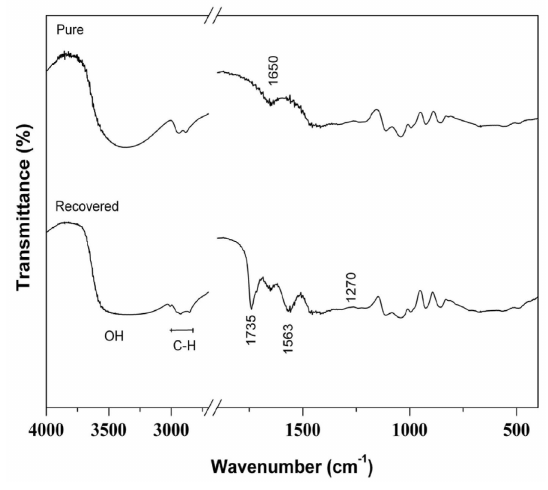
Figure 3. FTIR spectra of pure glycerol and recovered glycerol